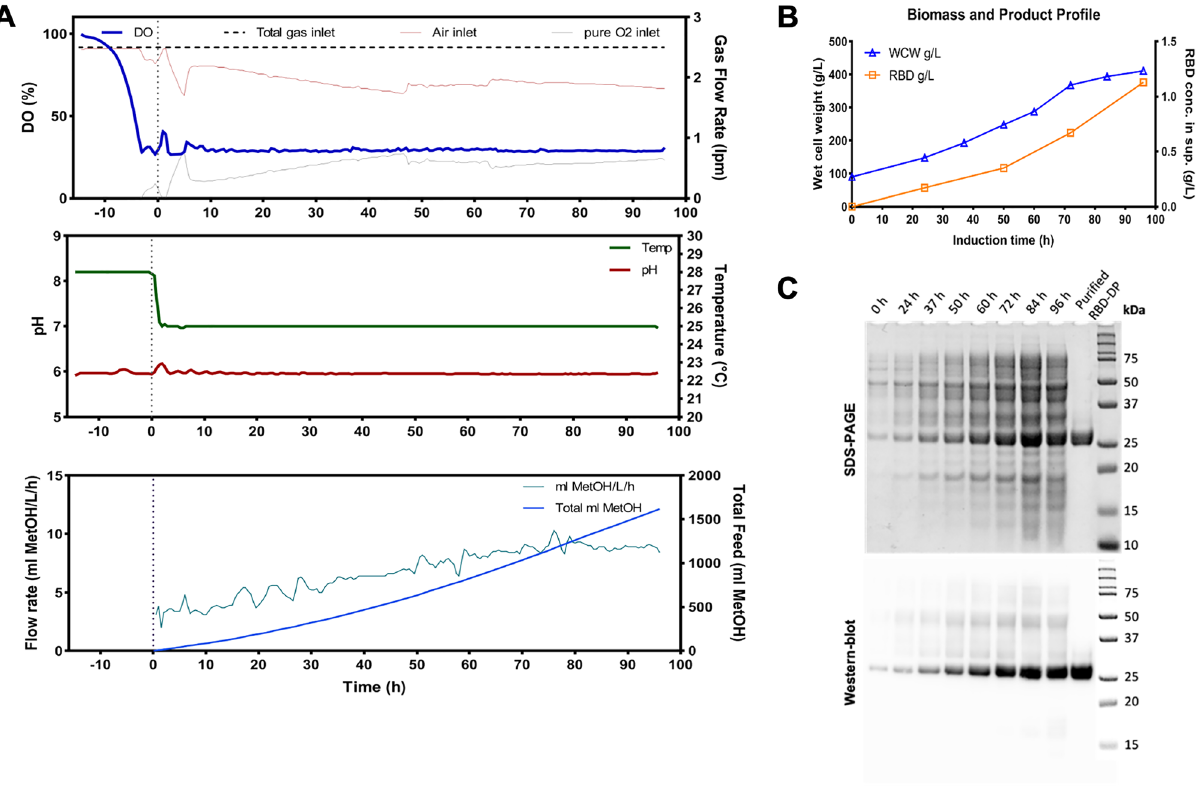
Figure 1. Fermentation process to produce RBD-DP at 5-L scale. ( A ) Course of dissolved oxygen tension (DO%) and ambient air/pure O 2 sparger inlet (top panel), course of pH and temperature (middle panel), and course of total methanol (MetOH) added and feed flow rate (bottom panel) of the two phase fermentation. On the x-axis, the time point of induction is marked as 0 (zero). ( B ) Biomass (wet cell weight, WCW) and RBD-DP product formation during the induction phase. ( C ) SDS-PAGE and Western blot analysis of the time-course fermentation supernatants (RBD-DP appears just above 25 kDa